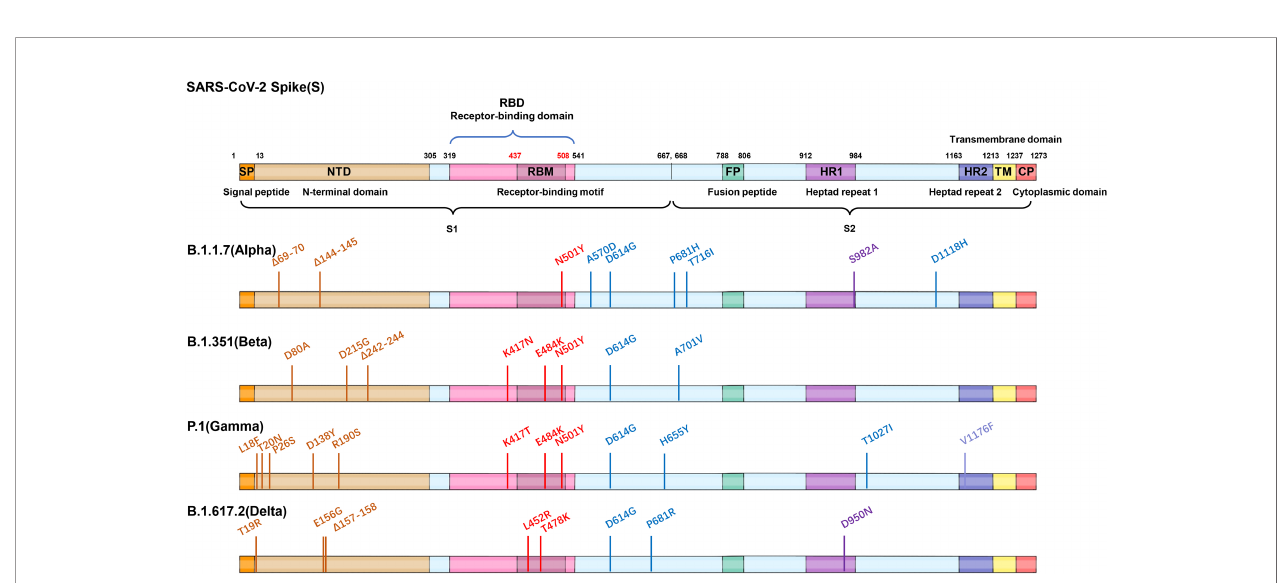
FIGURE 2 | Mutations of four VOC variants. Schematic showing the locations of amino acid substitutions of four VOCs (B.1.1.7, B.1.351, P.1, and B.1.617.2) in spike protein. The RBD region is shown in modena, the NTD region is shown in shallow